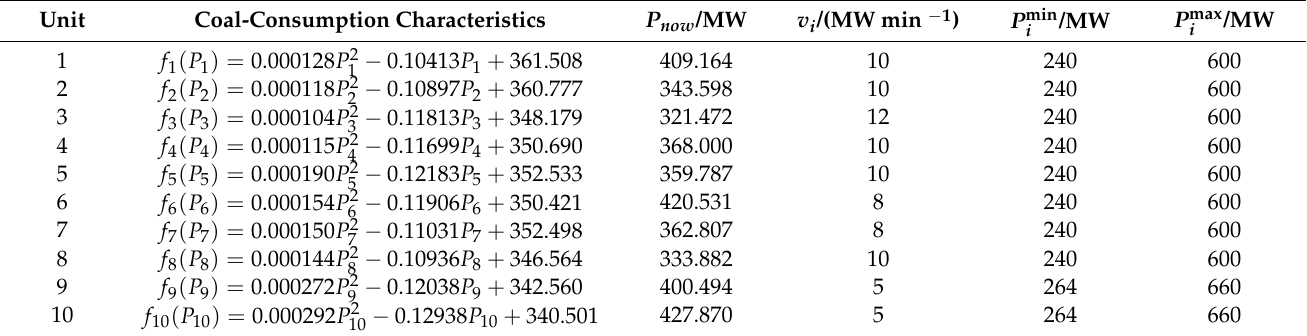
Table 10. Characteristics of 10 dispatched units based on economy and speediness with 10 similar- scale